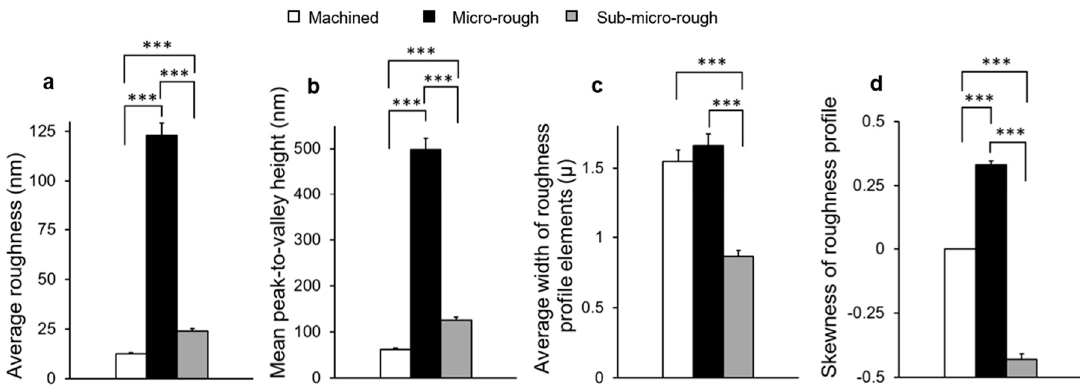
Figure 2. Quantitative measurements of surface roughness of the machined, micro-rough, and sub-micro-rough surfaces using a 3-dimensional profiler. ( a ) Average roughness, ( b ) mean peak-to-valley height, ( c ) average width of roughness profile elements, and ( d ) skewness of roughness profile. Each value represents the mean ± standard deviation of six sites on the three different surfaces ( n = 6). *** p < 0.001, one-way ANOVA followed by Tukey’s test.